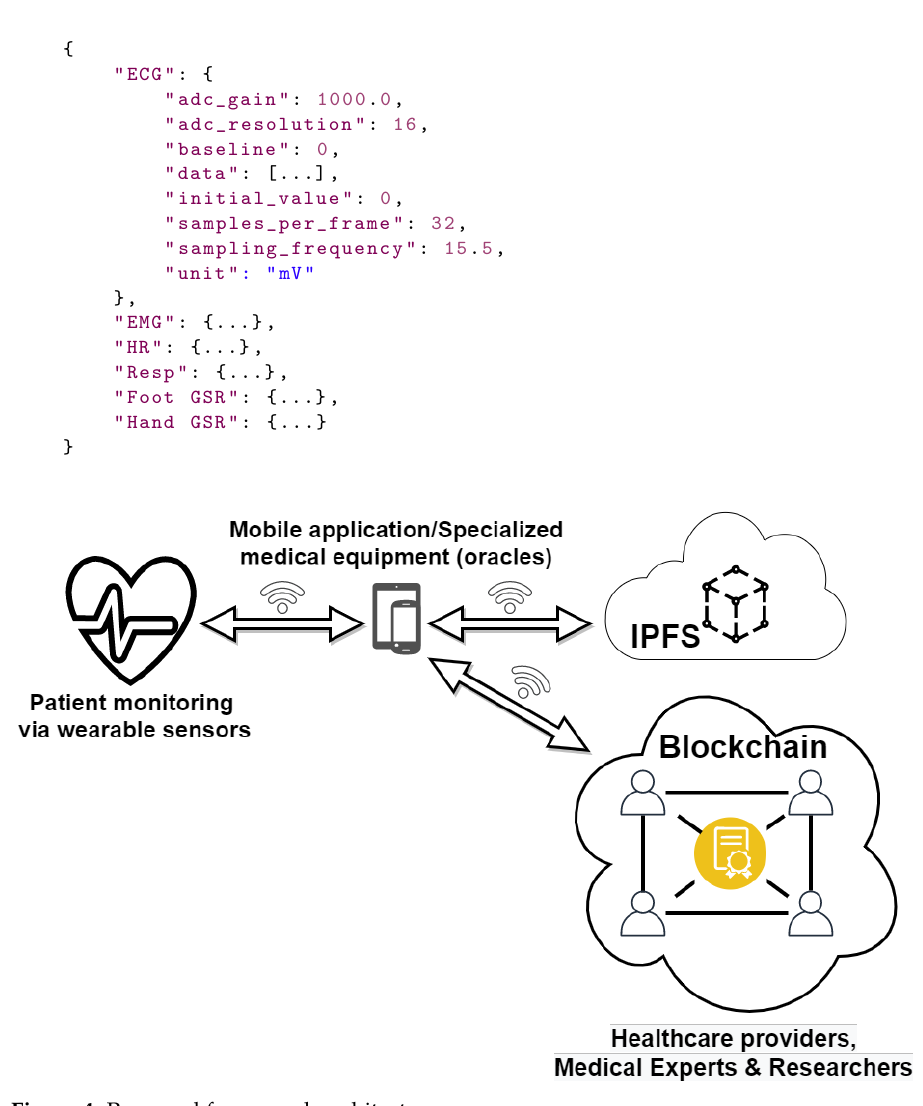
Figure 4. Proposed framework architecture.